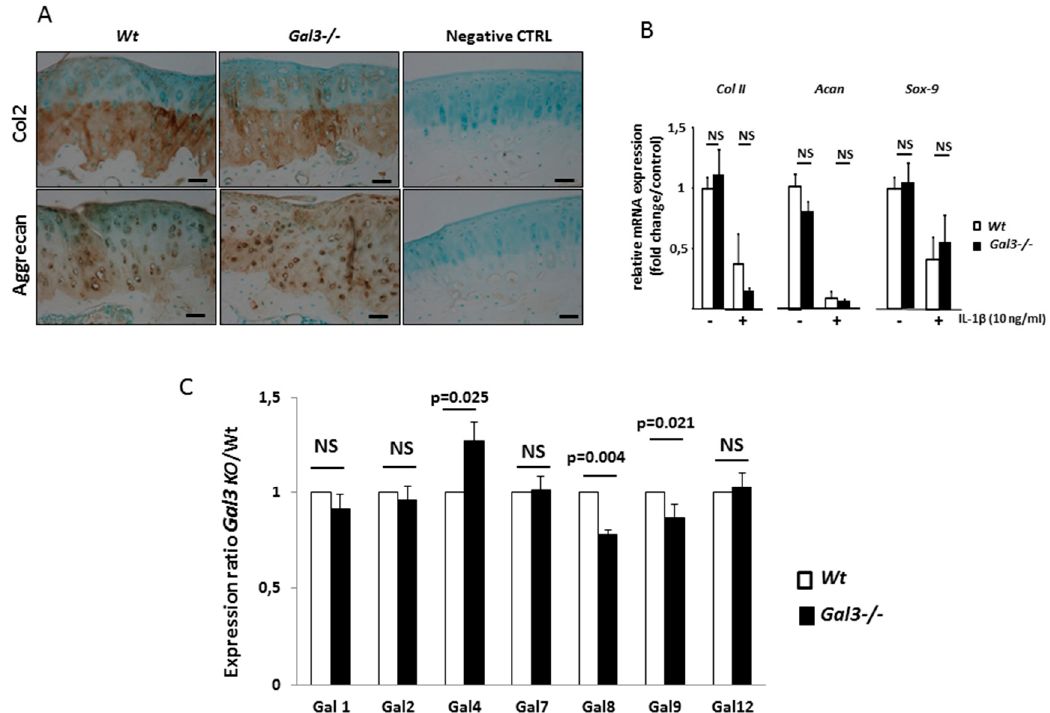
Figure 4. GAL3 deletion does not modulate chondrocyte anabolism. ( A ) Immunohistochemistry of expression of type II collagen and aggrecan in knee cartilage of WT and Gal3 − / − cartilages after MNX ( n = 5 of WT and Gal3 − / − mice). Scale bars: 100 µ m ( B ) qRT-PCR analysis of Coll II , Acan and Sox9 mRNA expression in cultured chondrocytes from articular cartilages of Gal3 − / − and WT newborn mice with and without IL-1 β stimulation (10 ng / mL) (201-LB / CF, R&D Systems, Lille, France) ( n = 5 independent experiments). ( C ) qRT-PCR analysis of Lgals1 , Lgals2 , Lgals4 , Lgals7 , Lgals8 , Lgals9 and Lgals12 expression in cultured chondrocytes from articular cartilage of Gal3 − / − newborn mice ( n = 5 independent experiments). Two-tailed Mann–Whitney U test between WT and Gal3 − / − .